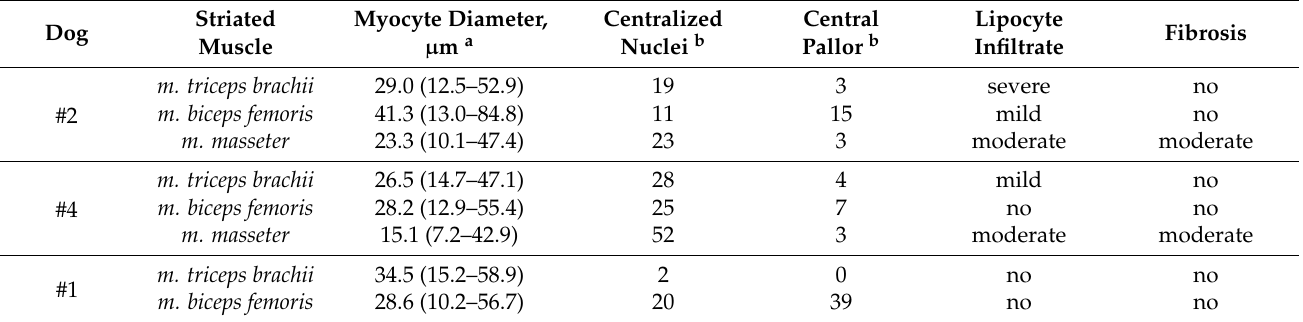
Table 4. Myocyte diameter and evaluation of centralized nuclei, clarity, lipocyte infiltration, and fibrosis in three English springer spaniels with dyserythropoietic anemia myopathy